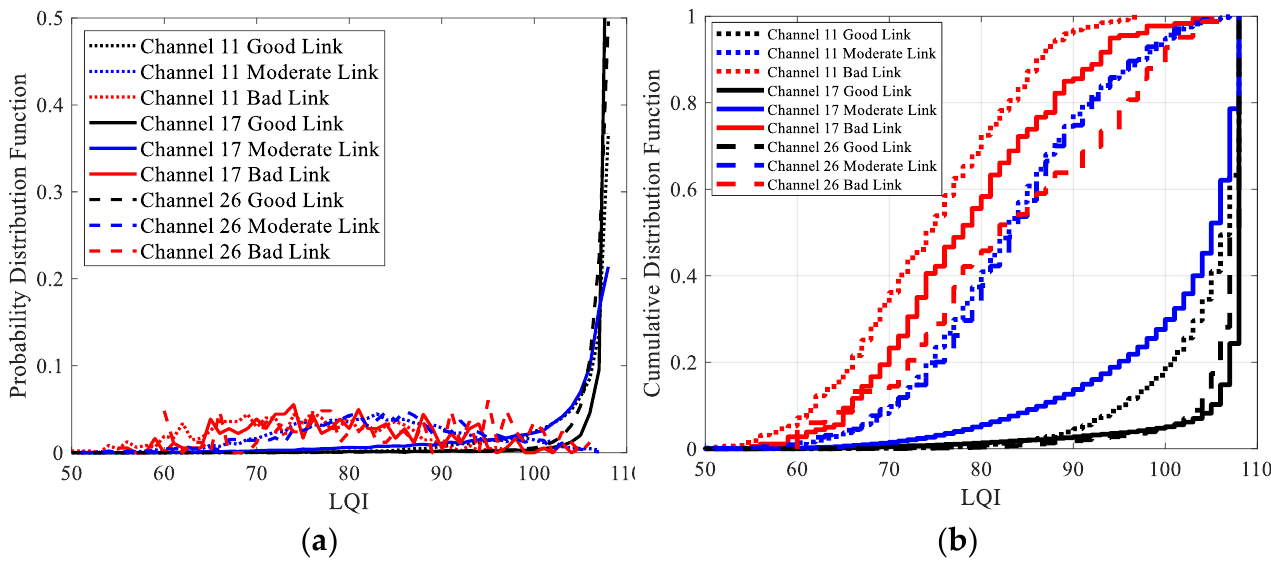
Figure 10. The distributions of LQI for good links, moderate links, and bad links under the interference-free channel 26, the low interference channel 11, and the high interference channel 17: ( a ) PDF; ( b ) CDF.